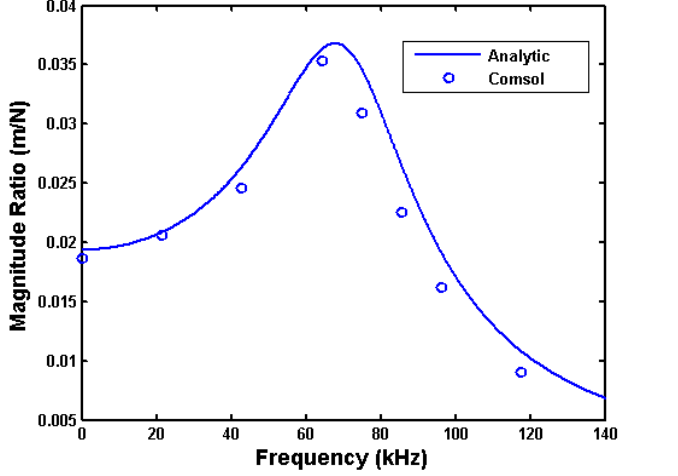
Figure 5. Comparison of analytical and numerical frequency responses for square plate